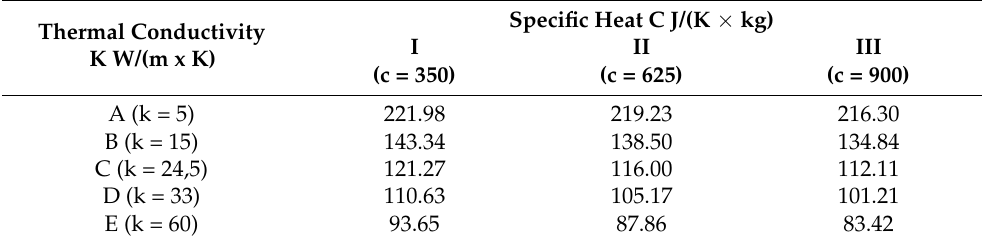
Table 5. Summary of the impact of thermal conductivity and specific heat on the maximum temperature of the carbon contact strip.